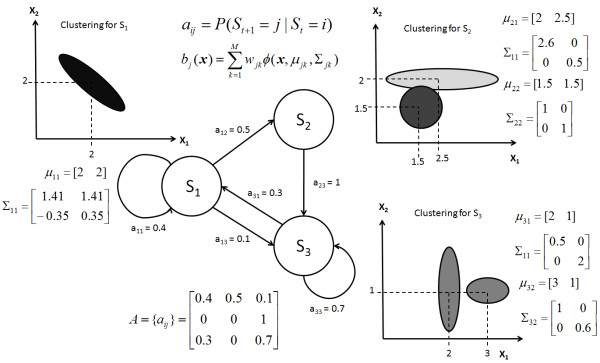
General schematic representation of hidden Markov model. A sample 3-state HMM with 2-D features space is illustrated. The state transition probably from state i to j is denoted by aij and the emission probability of having feature x in state j is denoted as bj(x). The mean μjk and covariance matrix Σjk of each cluster provide information on the center and distribution of information in the feature space.